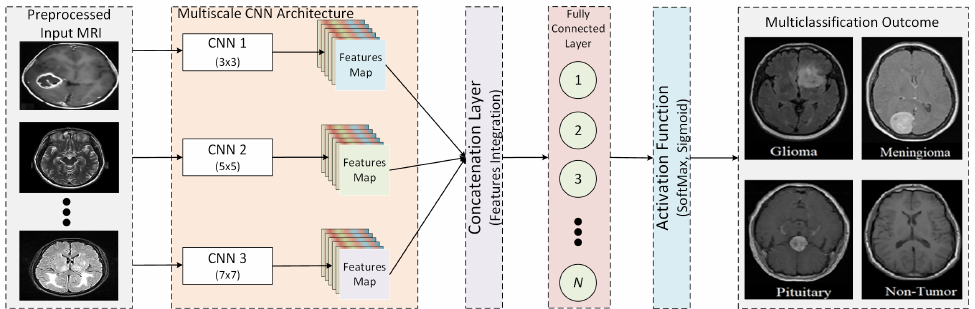
Figure 2. Block model of the proposed multi-scale CNN